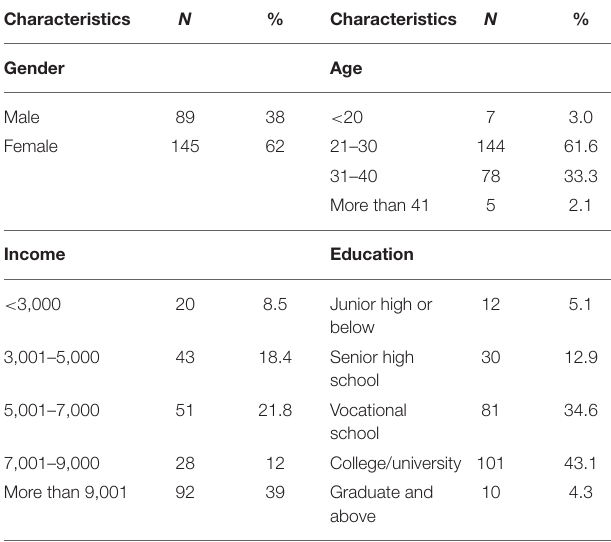
TABLE 1 | Demographic information of the